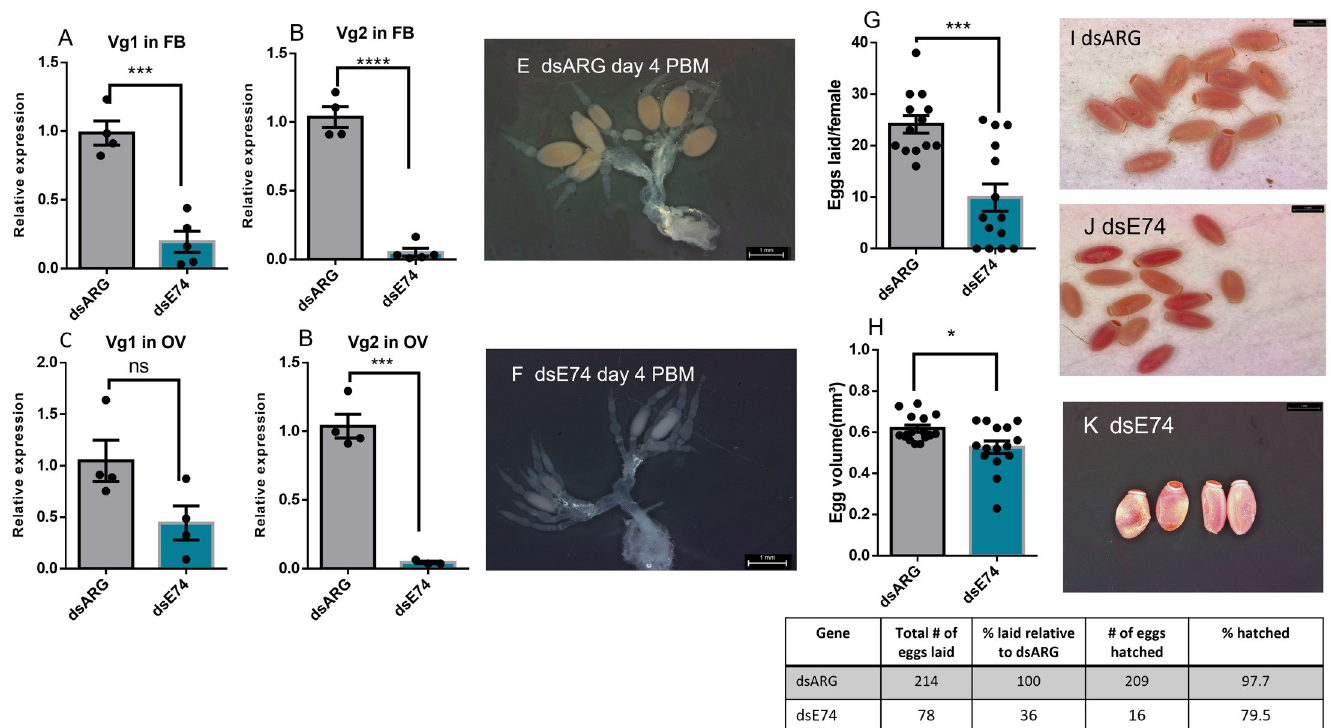
Fig 9. Effect knockdown of E74 mRNA in adult females on egg production. RT-qPCR was used to quantify the relative transcript levels of Vg1 and Vg2 in fat body (FB) and ovary (OV) at 4 d post blood meal (PBM) in dsARG (control) and dsE75-injected females. Vg1 in FB (A), Vg2 in FB (B), Vg1 in ovary (C), and Vg2 in ovary (D). dsE74-injection affects ovarian phenotype in comparison to dsARG-injected insects (control) (E and F) (n = 4). Eggs laid per female over 15 days PBM (G) (n = 15) and egg volume (H) (n = 15). Phenotypes of laid eggs from insects injected with dsARG (I) or dsE75 (J-K) (n = 15). At 4 days PBM, ovaries were dissected, and images were taken. Rp49 and β -actin were used as reference genes. The transcript levels were quantified using RT-qPCR and analyzed using the 2 − ΔΔ Ct method. Results are presented as mean ± SEM. Student’s t-test was used for statistical analysis. ��� p < 0.001, ���� p < 0. 0001.